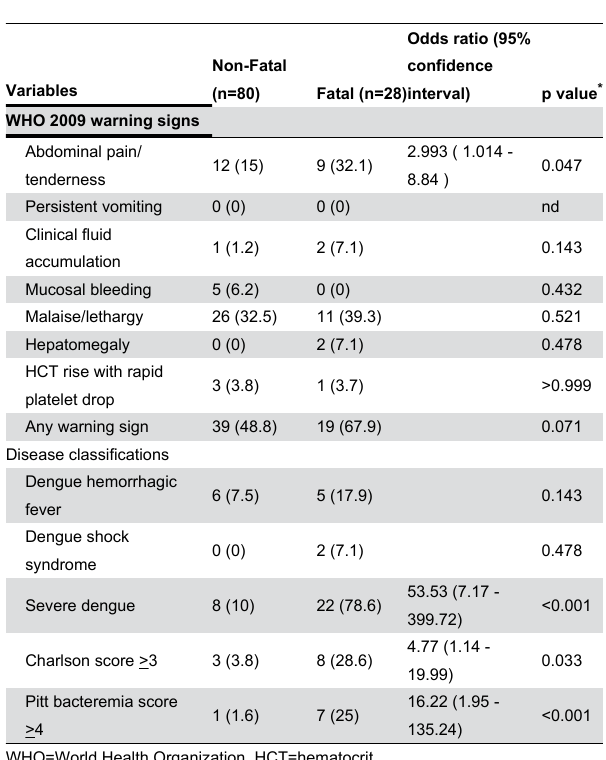
Table 2. Severity assessment at